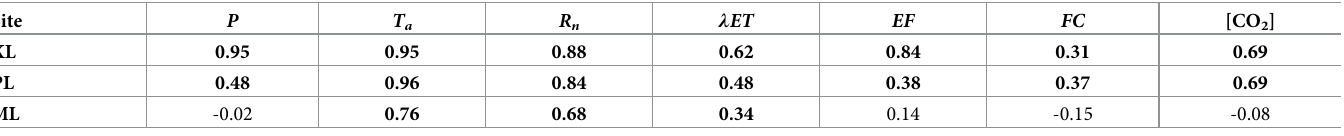
Bolded numbers indicate significant correlations at p �